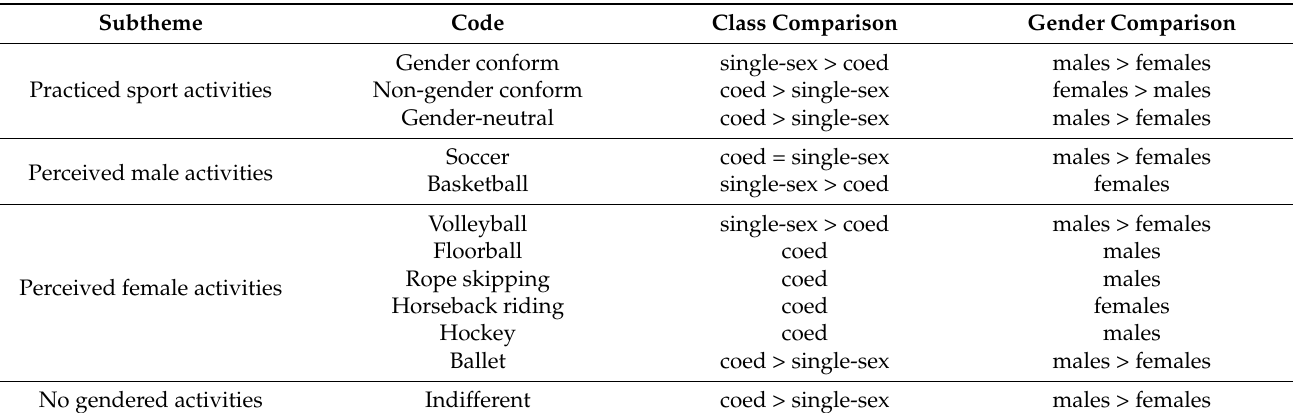
Table 3. Overviewofthesubthemesperceivedingenderedsportactivitieswithclassandgendercomparison. Subtheme Code Class Comparison Gender